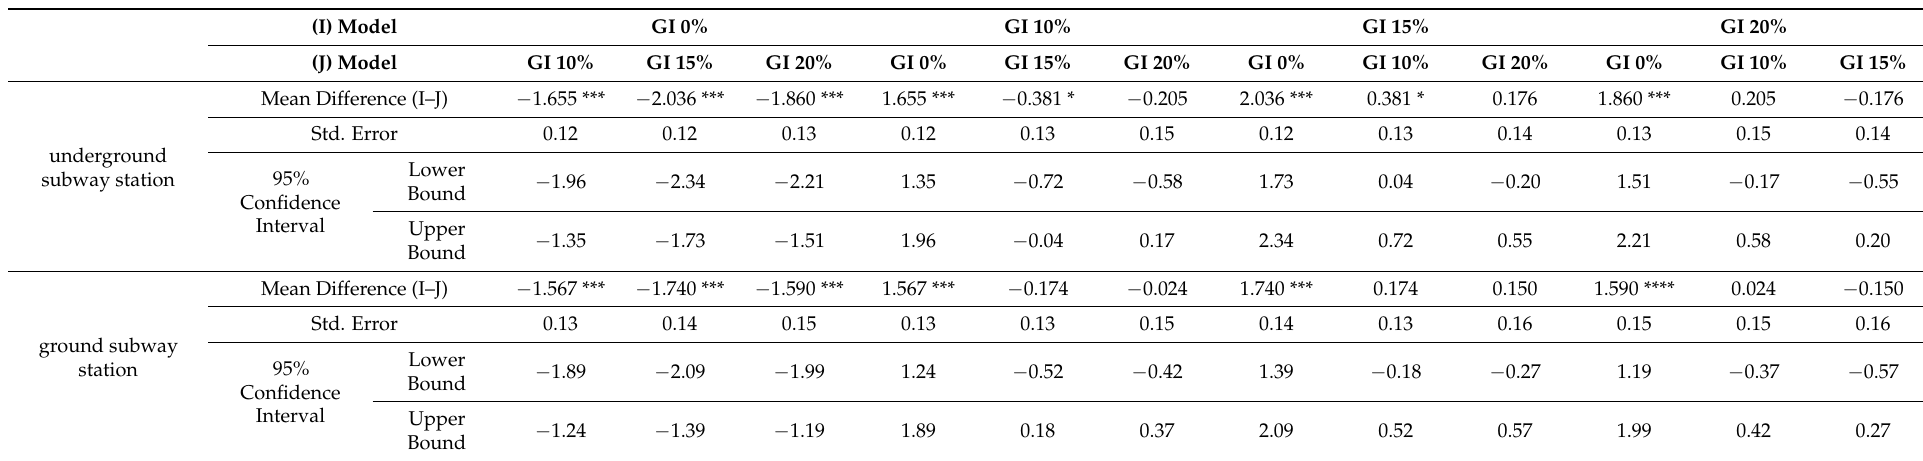
Table 9. Post-hoc Test for Interior Landscape Model Attention Restoration